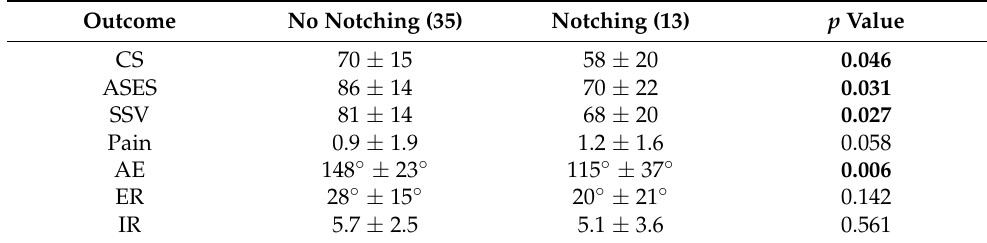
Table 3. Clinical outcomes according to notching at the last follow-up. No preoperative or demo- graphical differences were found between the two